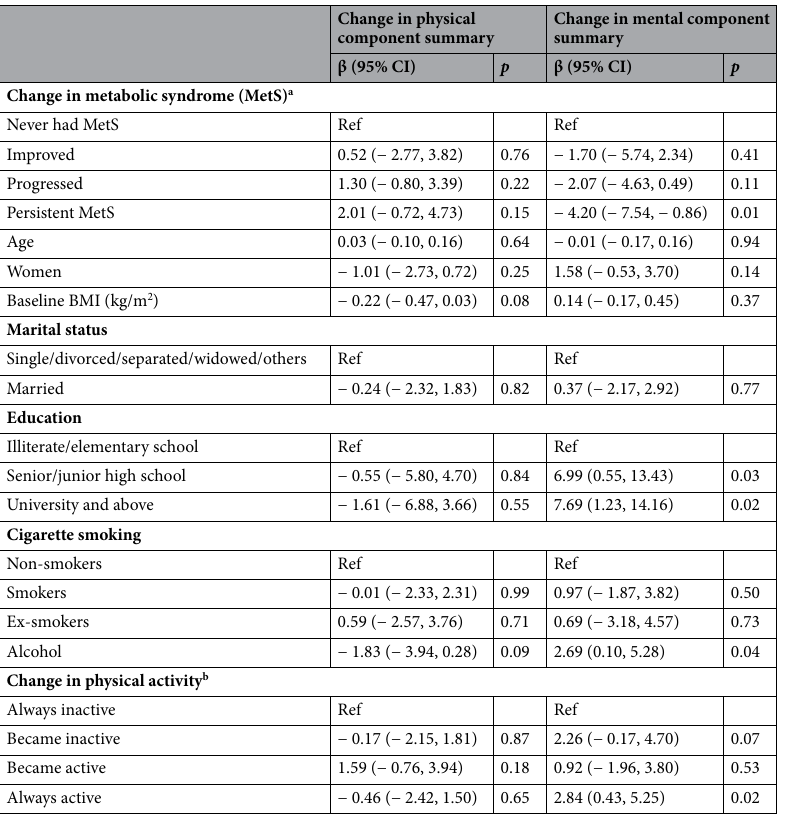
Table 3. The association between change in metabolic syndrome and change in health-related quality of life (n = 427). The analyses were conducted by multivariable linear regression. MetS metabolic syndrome, BMI body mass index. a There were 298 (69.8%) participants who never had MetS. 22 (5.2%) participants had